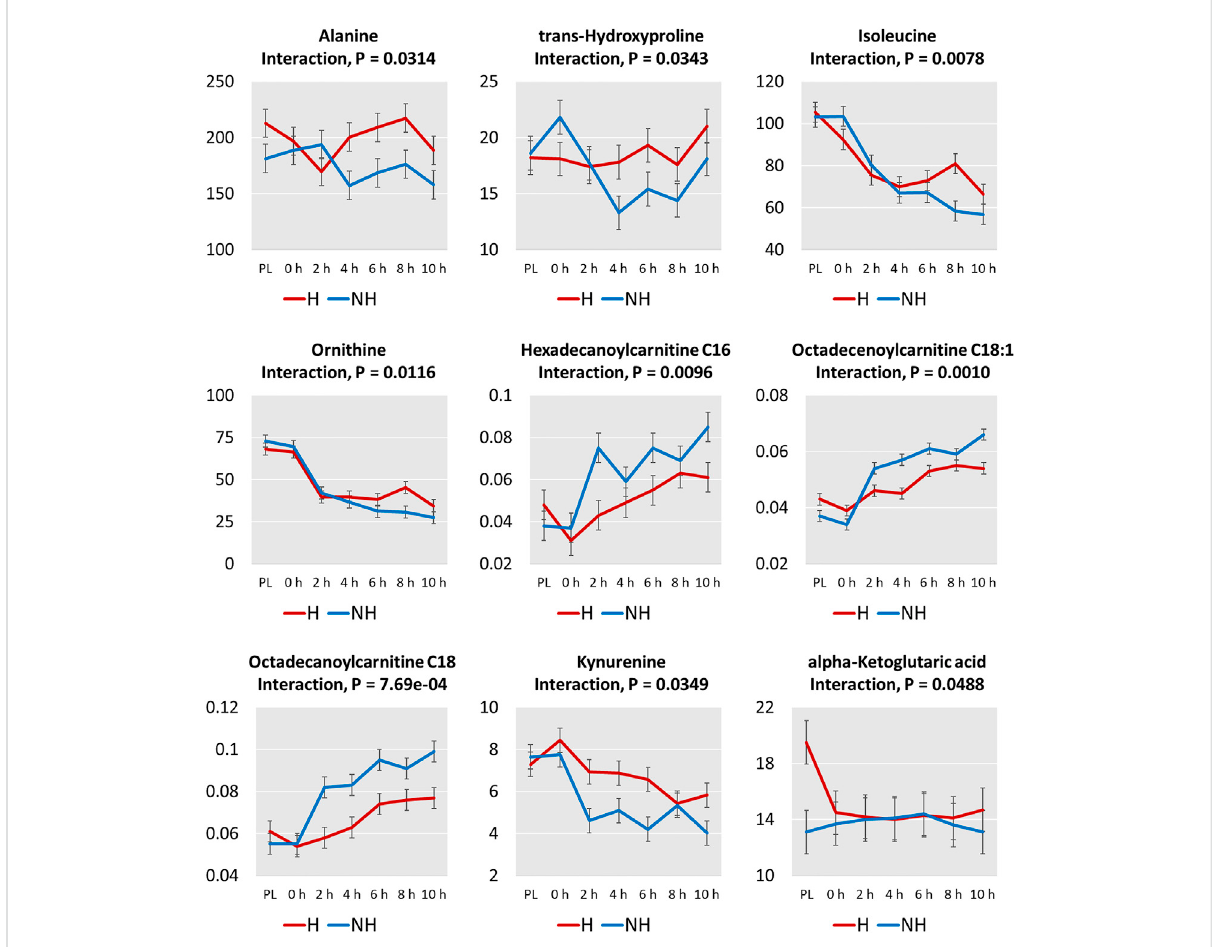
FIGURE 6 Plots of means (± SEM) of metabolites with signi fi cant treatment (H = Habituated; NH = Non-habituated) × transportation time (PL = Preload) interaction effects ( p <